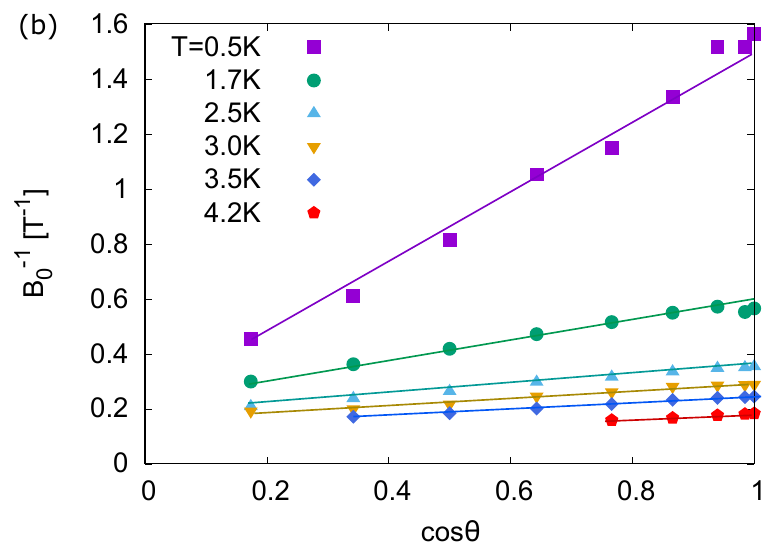
Figure 4. ( a ) theoretical results on cos θ dependences of B − 1 for T = 0.5 (open square), 1.7 (open circle), 0 2.5 (open triangle), 3.0 (inverted open triangle), 3.5 (open diamond), and 4.2 K (open pentagon). When cos θ is close to 1, numerical results show a relation 1/ B 0 ∼ = a cos θ + b approximately, where a and b are independent of θ . ( b ) experimental results on cos θ dependences of B − 1 for T = 0.5 (filled square), 0 1.7 (filled circle), 2.5 (filled triangle), 3.0 (inverted filled triangle), 3.5 (filled diamond), and 4.2 K (filled pentagon). As with the theoretical results, the experimental results show relation 1/ B 0 ∼ = a cos θ + b approximately when cos θ is close to 1.